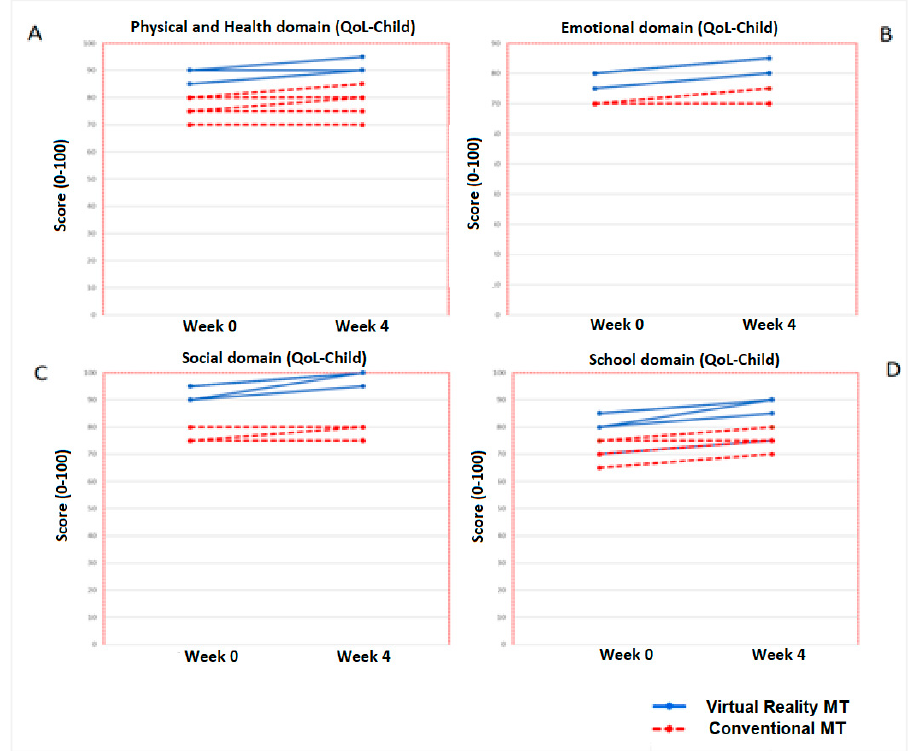
Figure 9. Progression of the Quality of Life-Child (domains) in the five children of the Virtual Reality MT and the five children who performed Conventional MT. In the picture ( A ), it can be seen the progression of the Physical and Health domain. The picture ( B ) shows the Emotional domain evolution, the picture ( C ), the progression of the Social domain and the progression of School domain is represented in the picture ( D